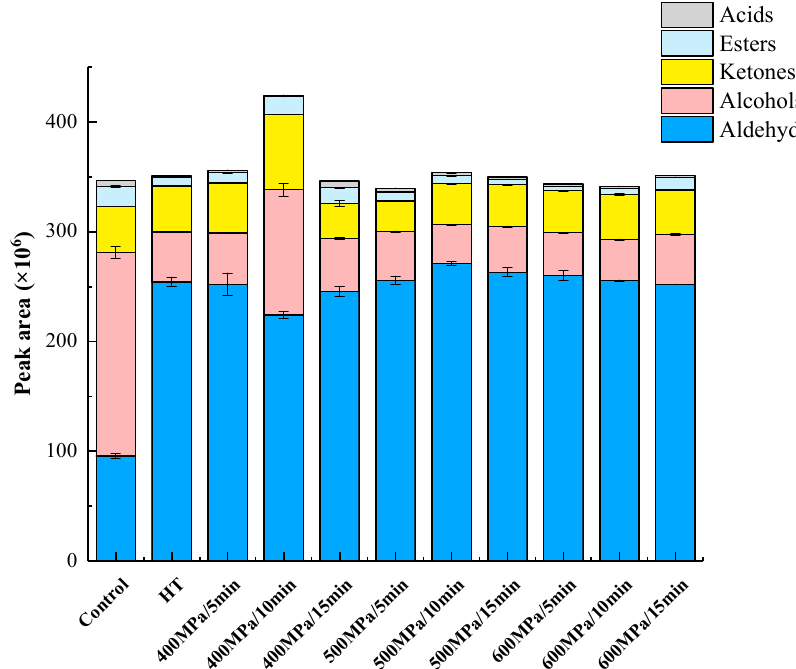
Figure 6. Effect of HHP treatment on volatile groups in kiwifruit pulp beverage on day 0. Control, kiwifruit pulp beverage treated without HT or HHP. HT, heat treatment (85 °C for 10 min). HHP, high hydrostatic pressure (400–600 MPa for 5–15 min). Results were expressed as means ± SD, n = 3.